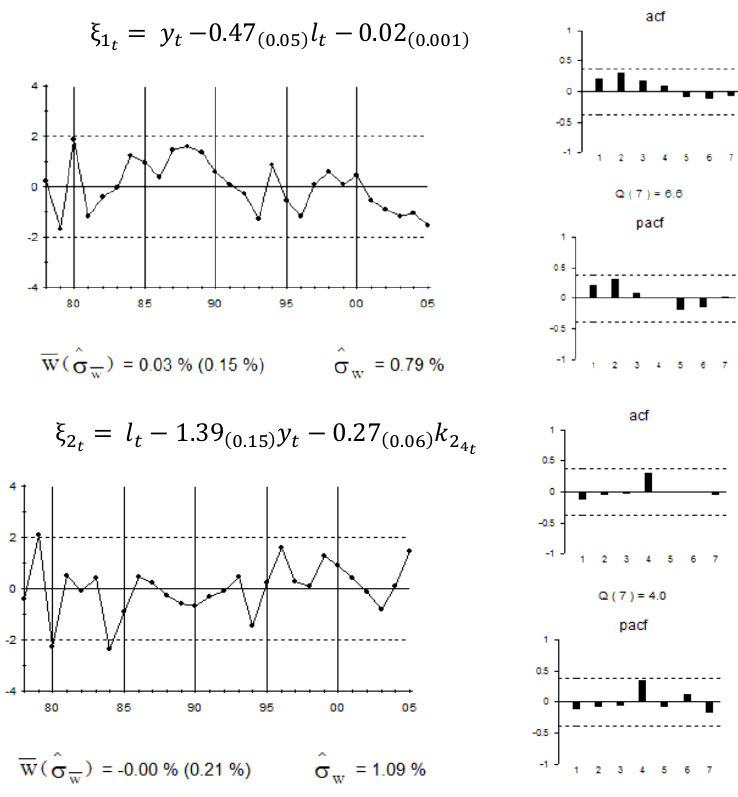
Figure 5. Cointegration